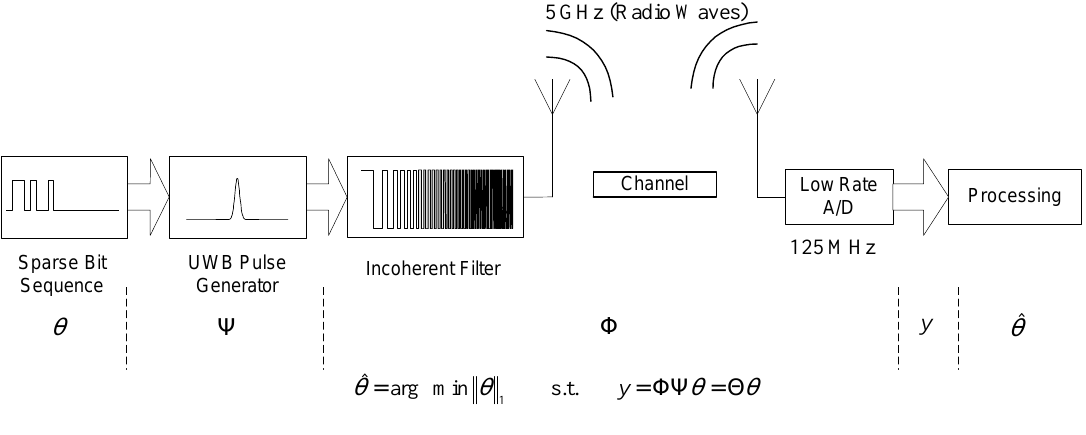
Figure 27. The structure of the K -sparse transmitted